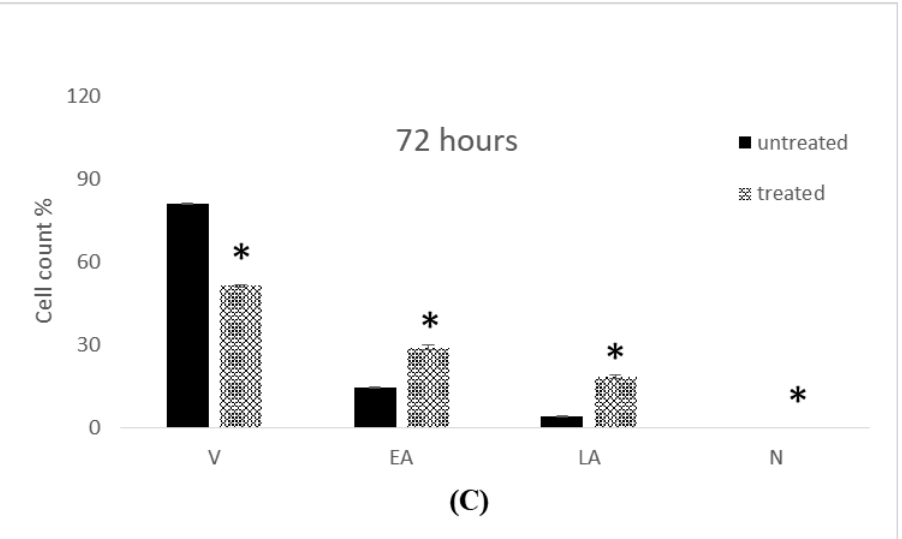
Figure 18. Annexin V-FITC assay of MCF-7 cell line determined using flow cytometry. The percent- age of viable, early apoptotic, late apoptotic and necrotic cells of untreated and treated MCF-7 cells. ( A ) 24 h, ( B ) 48 h and ( C ) 72 h. Each data point represents the mean of three independent experi- ments ± SD. * Significantly different from the control ( p < 0.05). V: viable; EA: early apoptosis; LA: late apoptosis; N: necrosis.